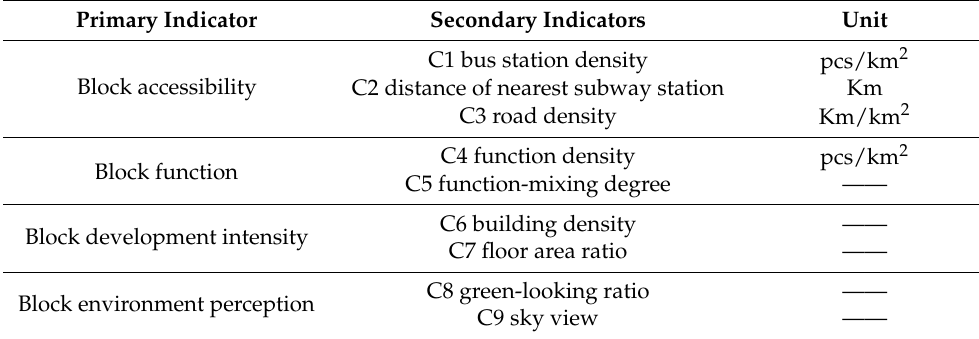
Table 2. Indicator system.